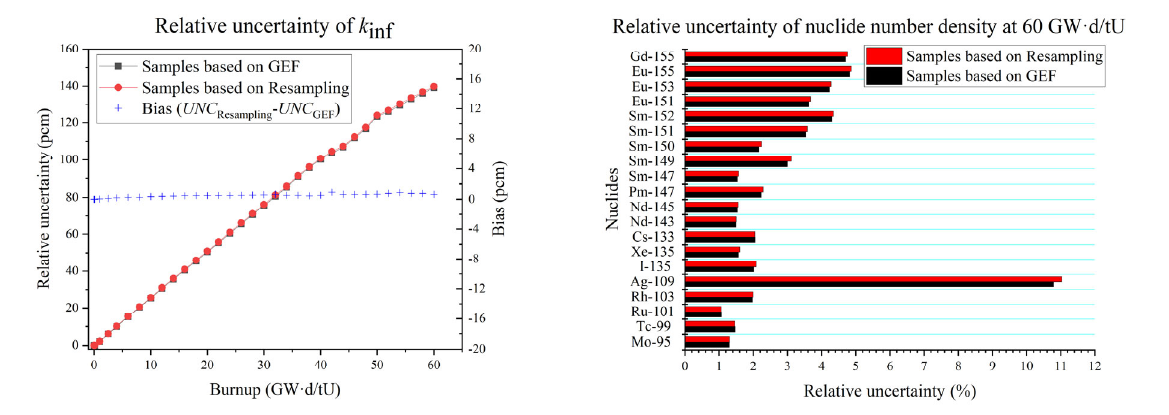
Fig.3. Comparison of uncertainties of the TMI-1 problem based on fission yield samples of 239 Pu+n th .